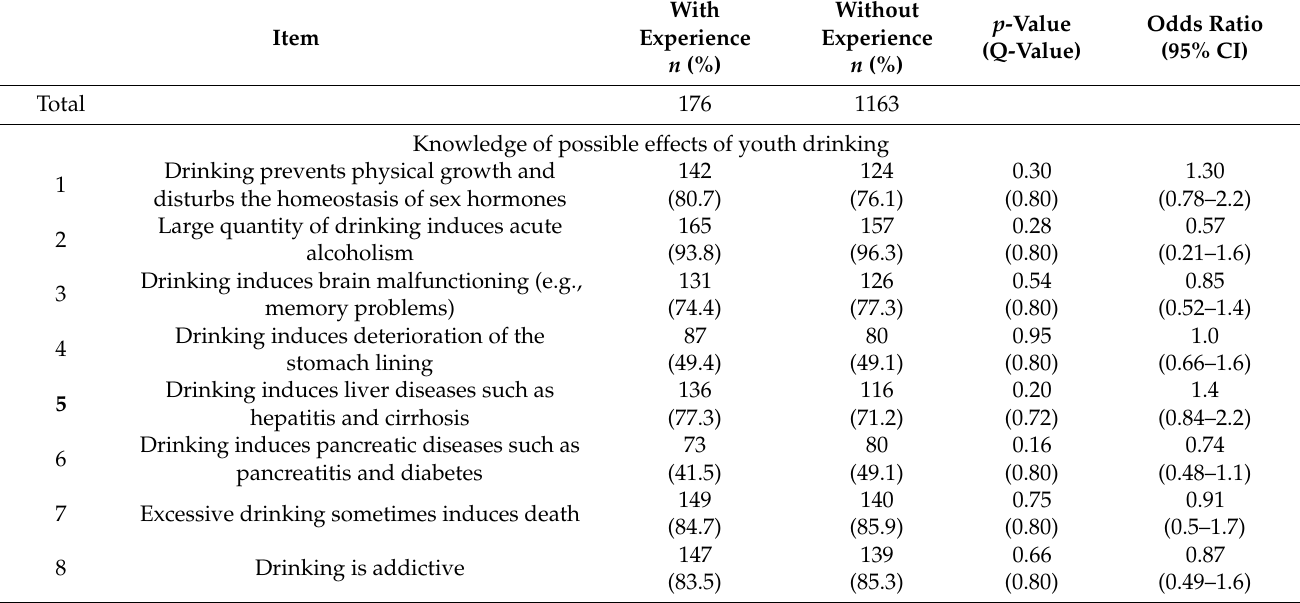
Table 3. Comparison of parents with/without the experience of initiating alcohol drinking in their